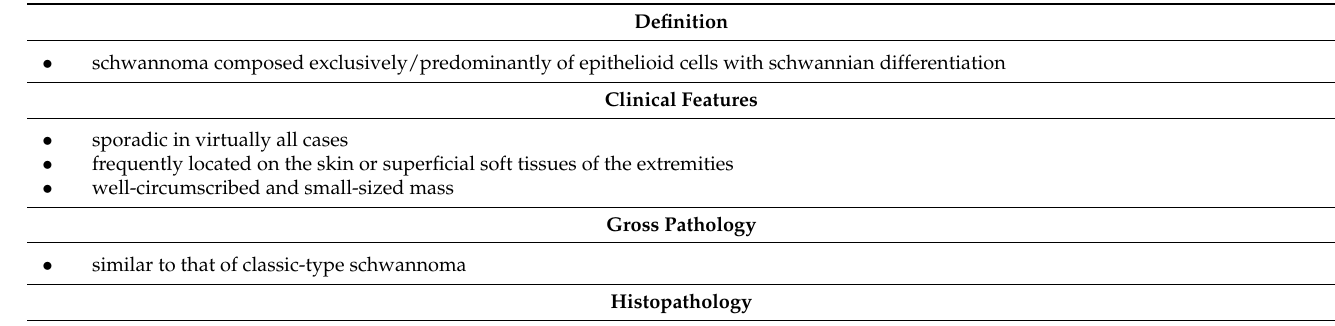
Table 12. Key diagnostic features of epithelioid cell schwannoma.